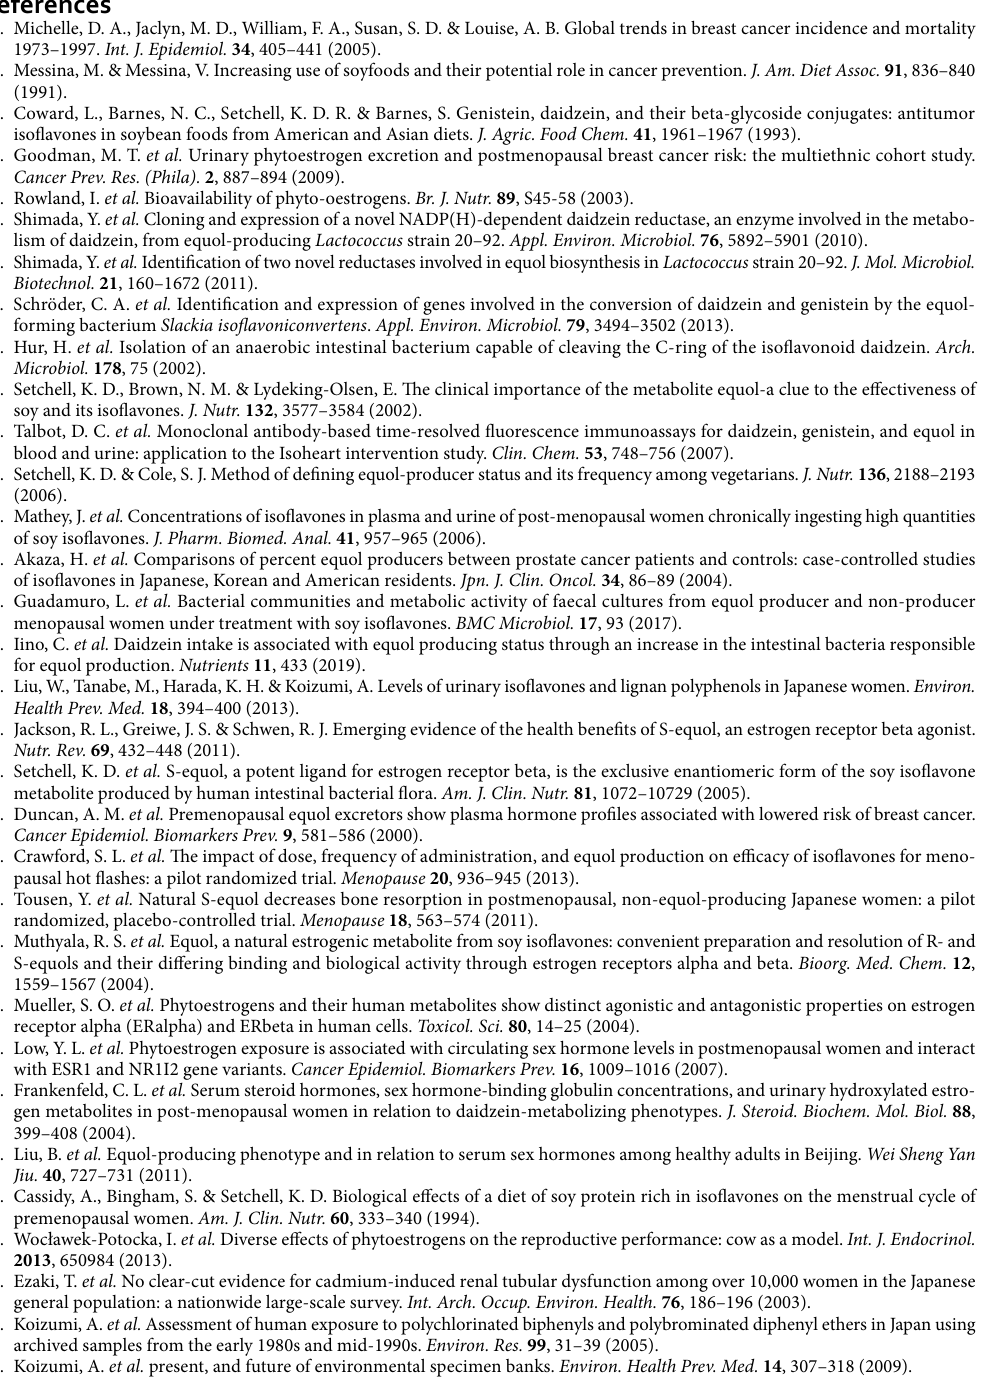
(Supplementary Table S2). Their β parameters and model fitness values were lower than those of E2 or 4-OHE2, indicating that E2 is the primary target of the effects of equol. The further studies are needed to clear the causal effect of equol with internal E2 levels. In conclusion, our findings suggest that equol may promote urinary E2 excretion and modify moderately blood E2 levels in women. All data generated or analyzed during this study are included in this published